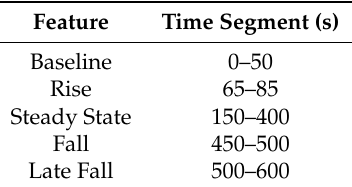
Table 3. Sensor response feature segments.